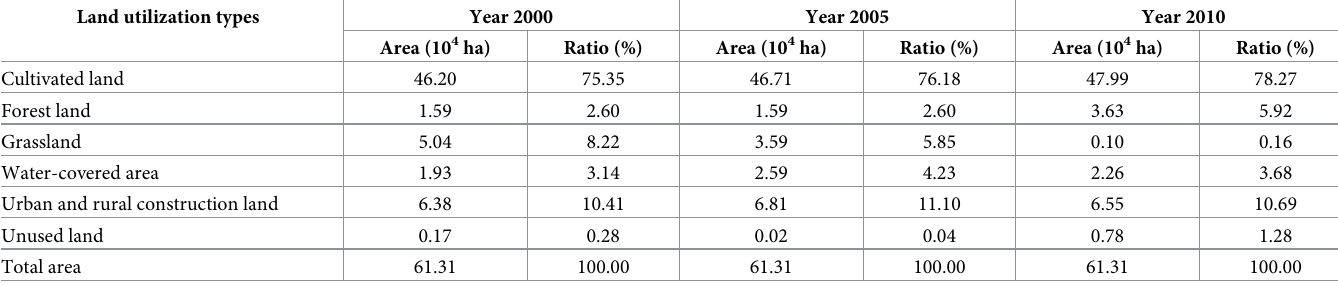
Data sources: The land use data were developed through remote sensing classification (from aerial imagery and SPOT5 satellite imagery) and field validation (classification accuracy: 93–95%).